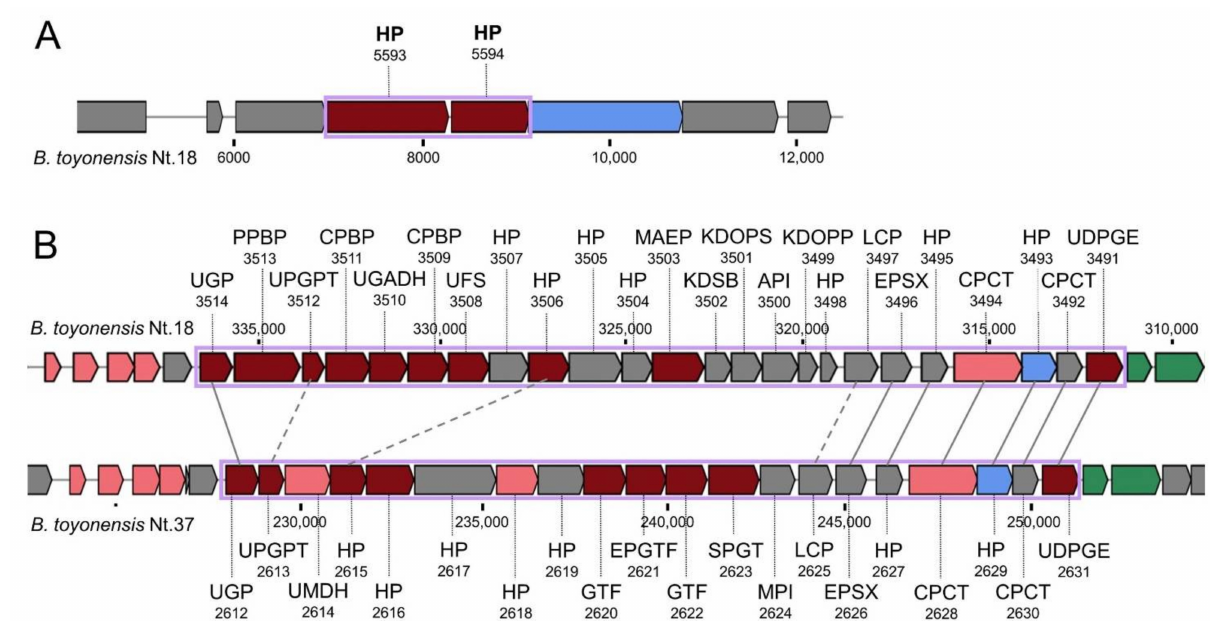
Figure A2. Structure of secondary metabolite biosynthetic gene clusters No. 36 LAP ( A ) and No. 20 EPS related ( B ), identified using the antiSMASH server. Text and number for the CDS labels correspond to protein symbol as indicated in Appendix A, Table A5, and feature number as indicated in Supplementary Materials Tables S1 and